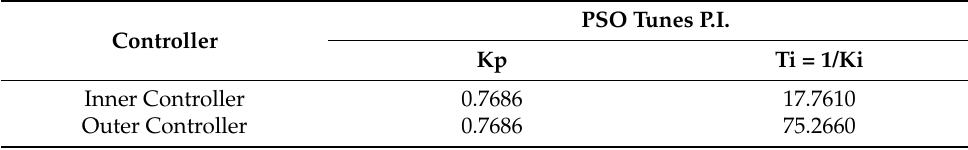
Figure 13. The performance index of Mayfly optimization for the 10 iterations. Table 3. MA optimized parameters.